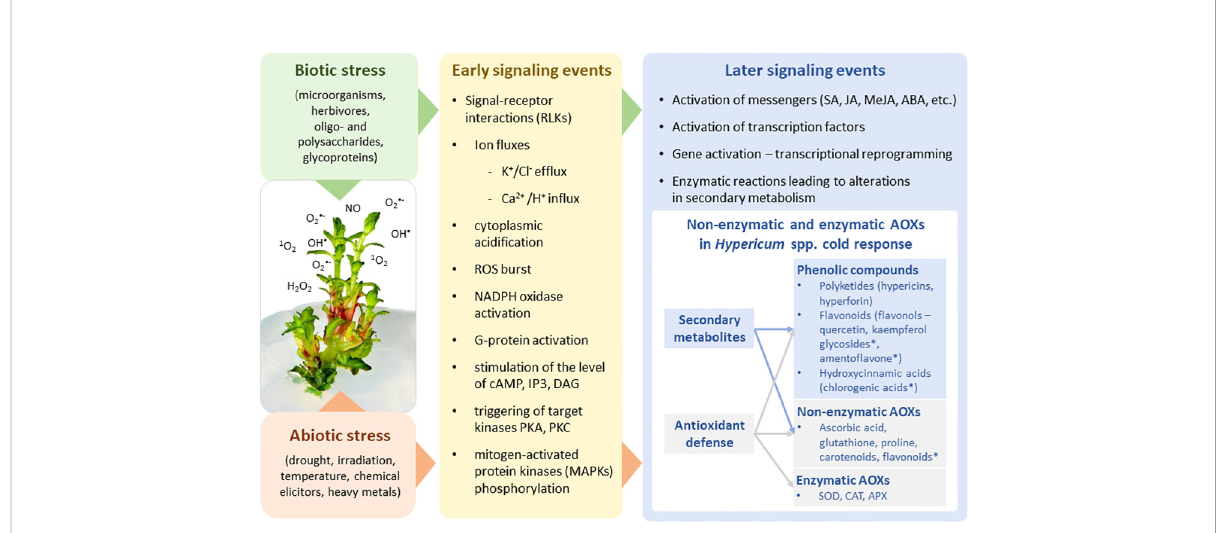
FIGURE 1 The biotic/abiotic stress signaling pathways comprising the stress perception, signal transduction, and expression of speci fi c stress-related genes resulting in modulation of plant primary and secondary metabolism. Metabolites highlighted by an asterisk are the markers with predictive value in cold-stress response of Hypericum